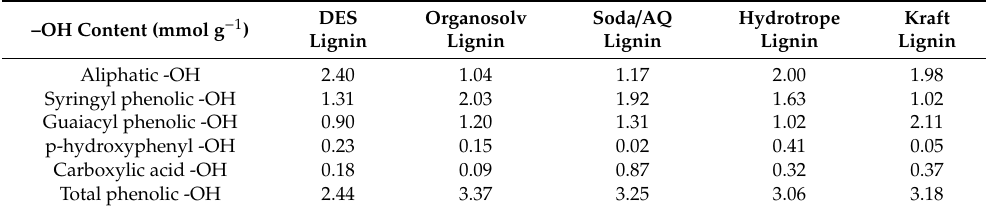
Figure 1. Quantitative 31 P NMR spectra of these four technical lignins and Kraft lignin tagged TMDP phosphorous reagent using cyclohexanol as internal standard. Table 1. Contents and locations of various hydroxyl groups in these five lignins quantified by 31 P NMR